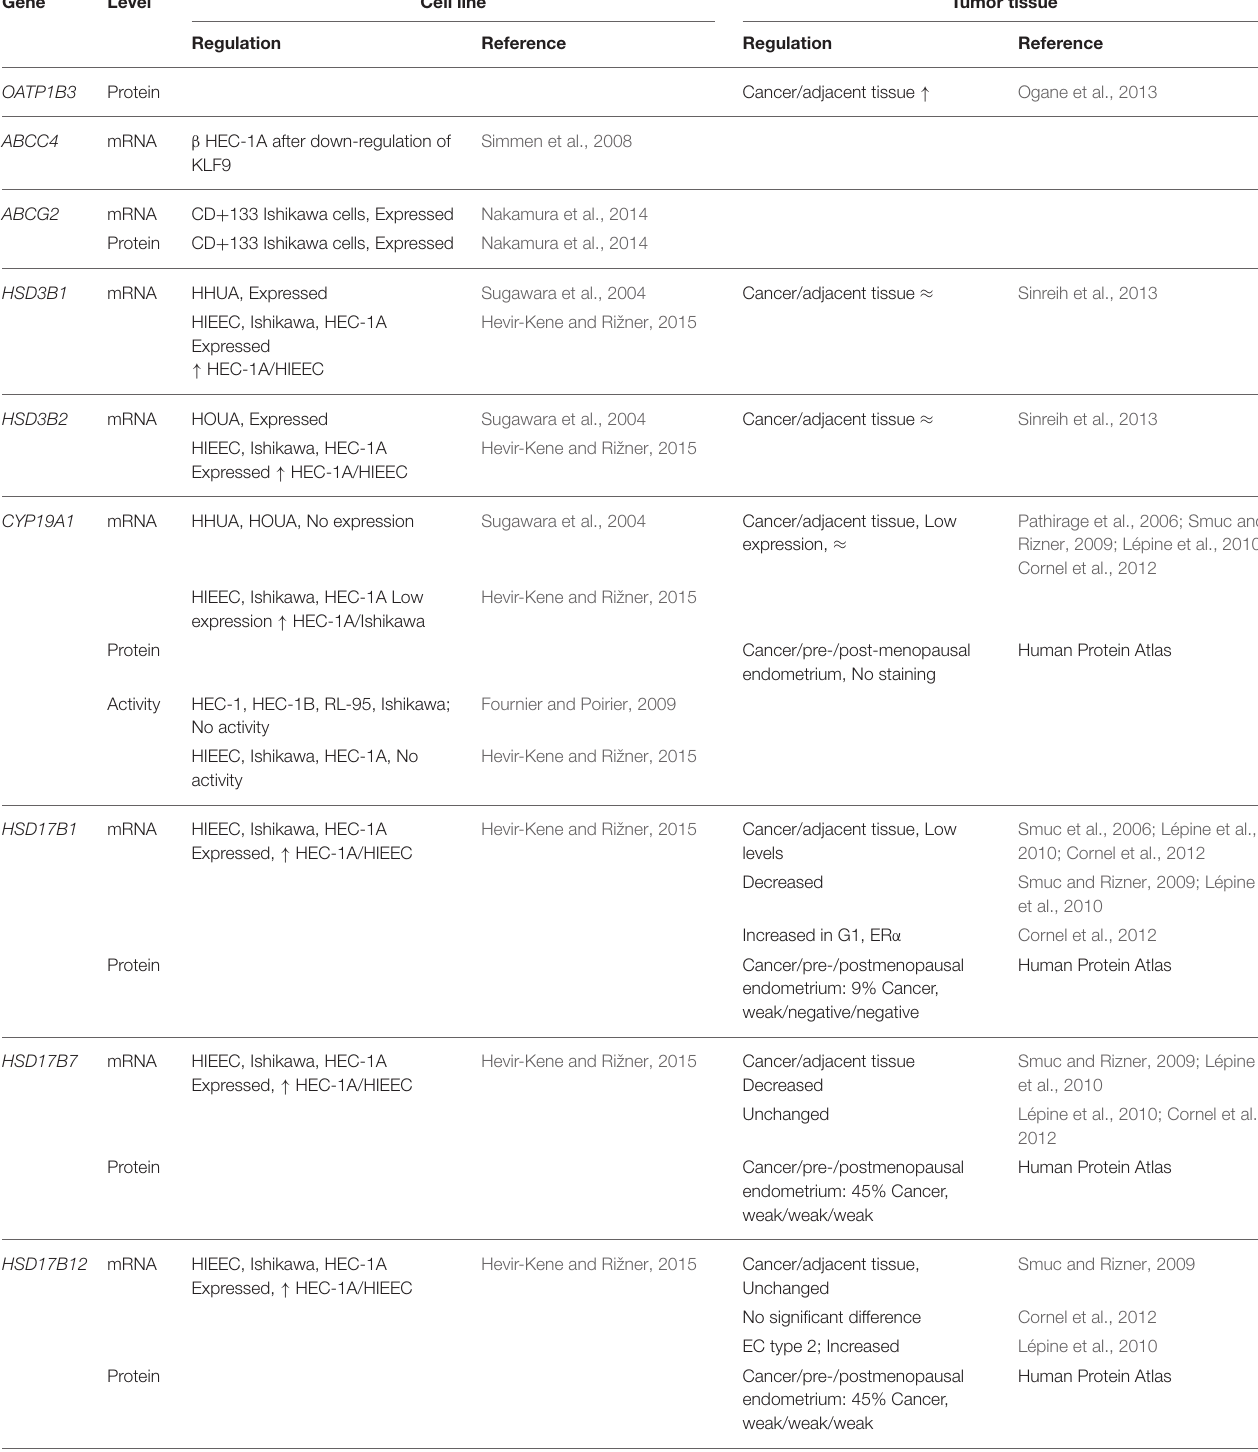
TABLE 3 | DHEA-S and E1-S transporters and estrogen biosynthetic enzymes in endometrial cancer. Gene